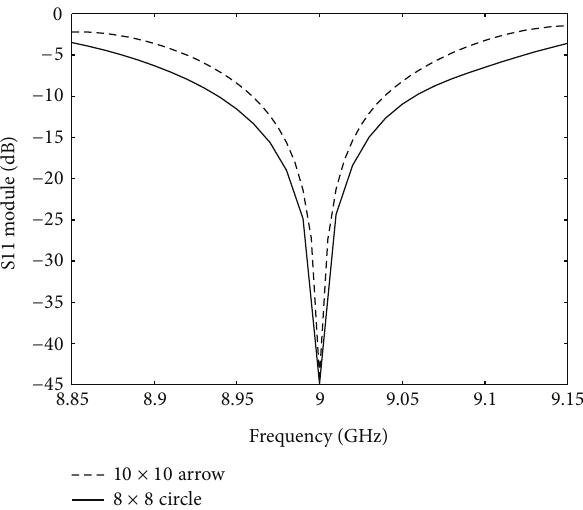
Figure 10: Simulated frequency responses (HFSS) of the designed arrays.